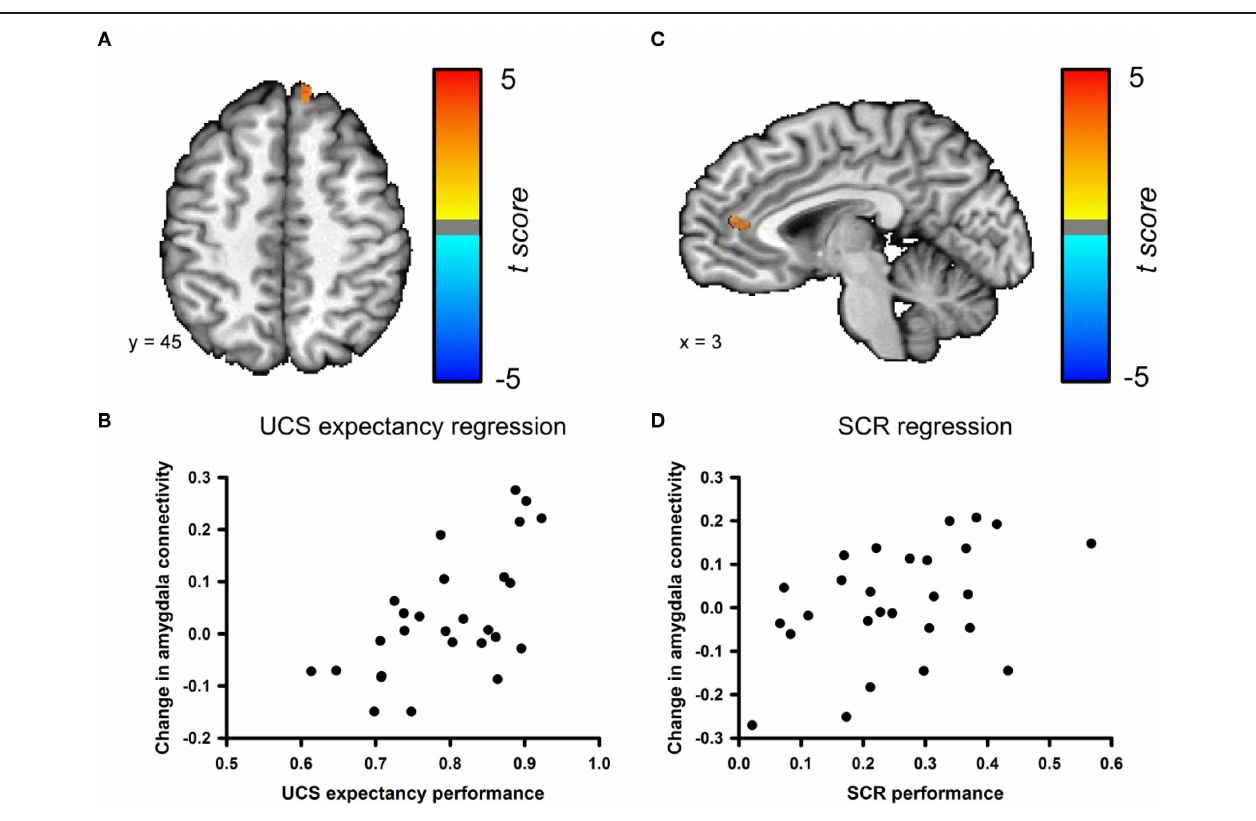
FIGURE 6 | Changes in amygdala connectivity are related to behavioral performance. (A) Connectivity changes between the amygdala and the superior frontal gyrus [Talairach coordinates: 11, 48, 9] are positively correlated with UCS expectancy performance during the conditioning task. (B) Scatter plot depicting UCS expectancy performance and change in